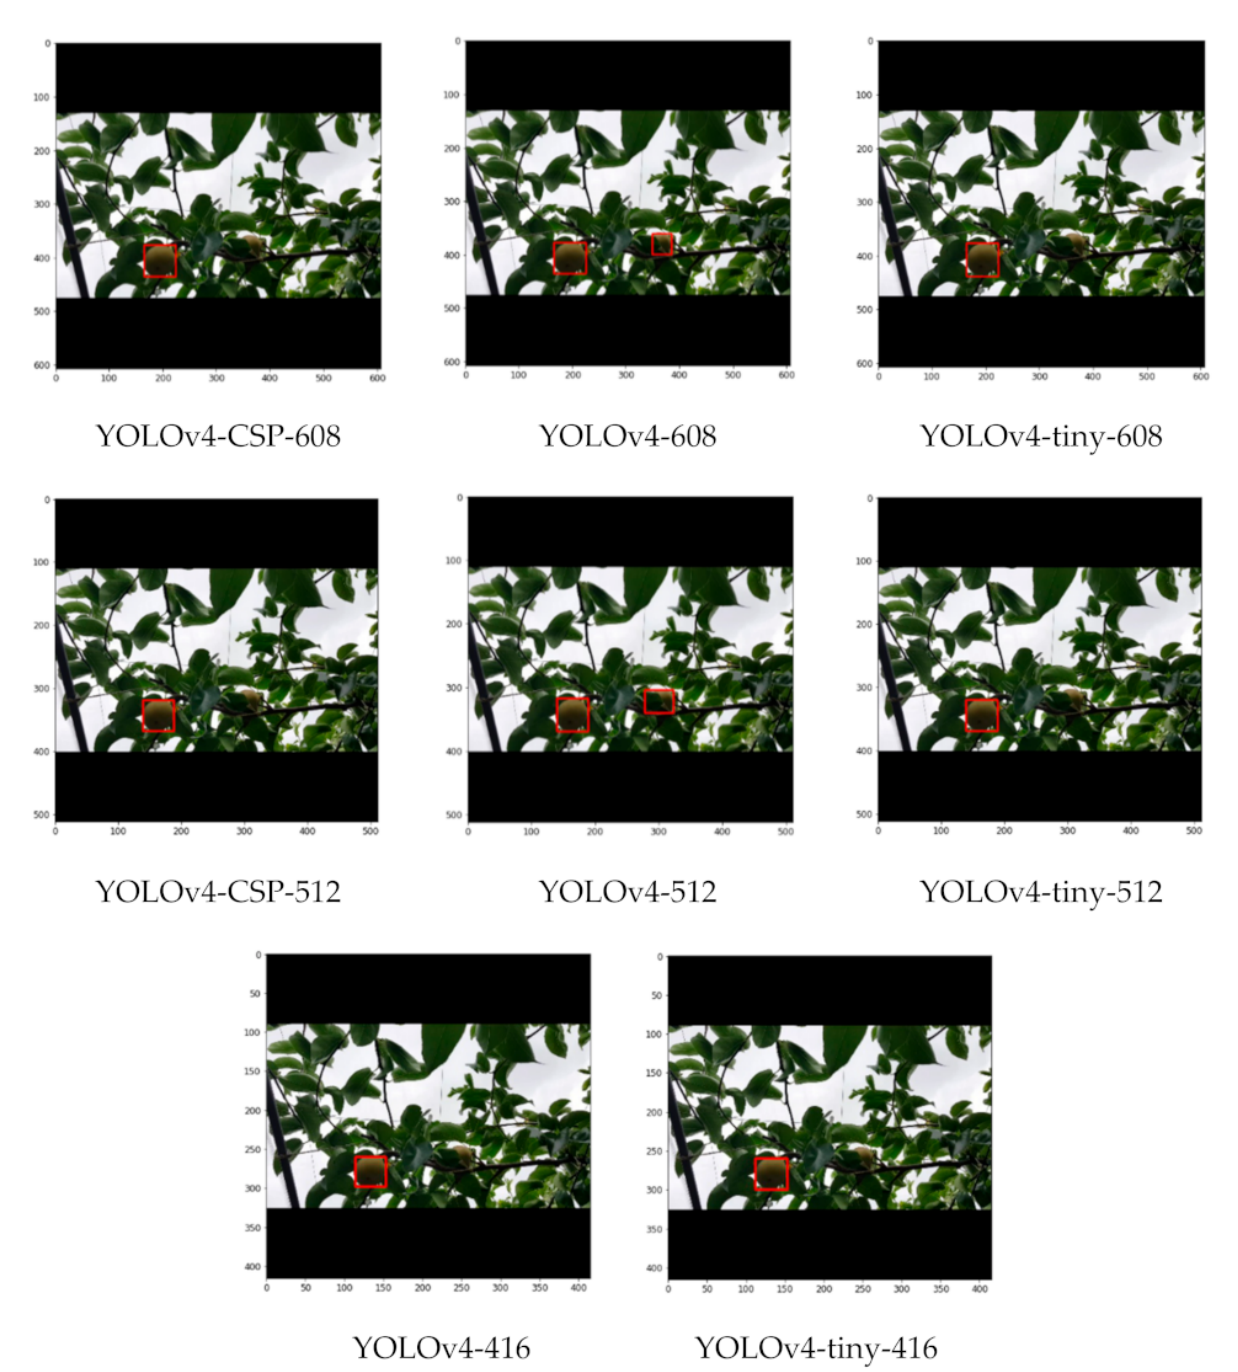
Figure 22. Example detections from the different YOLOv4 models using a nonclose-up image with a moderate degree of